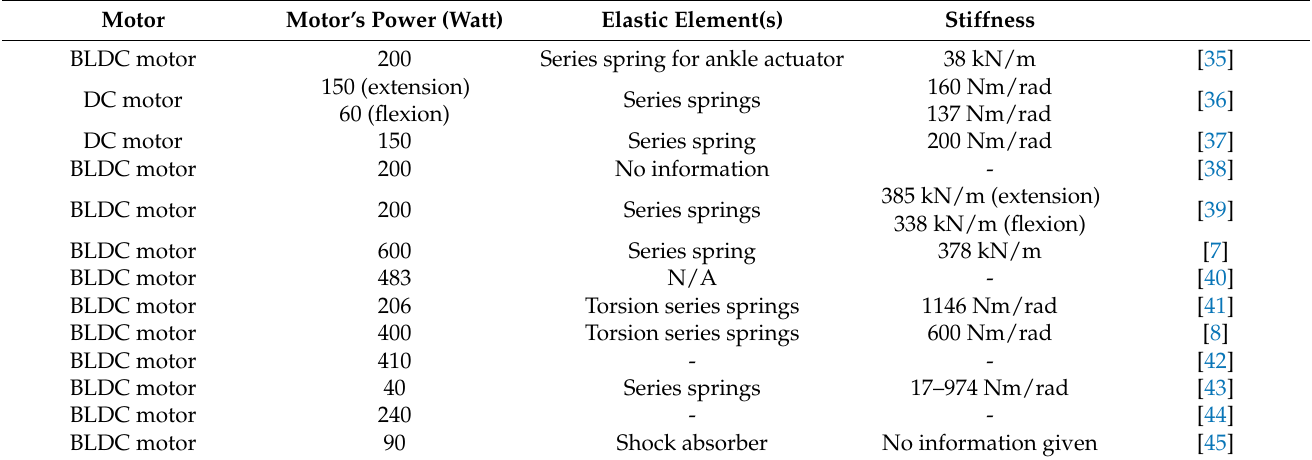
Table 2. Transfemoral robotic prosthesis